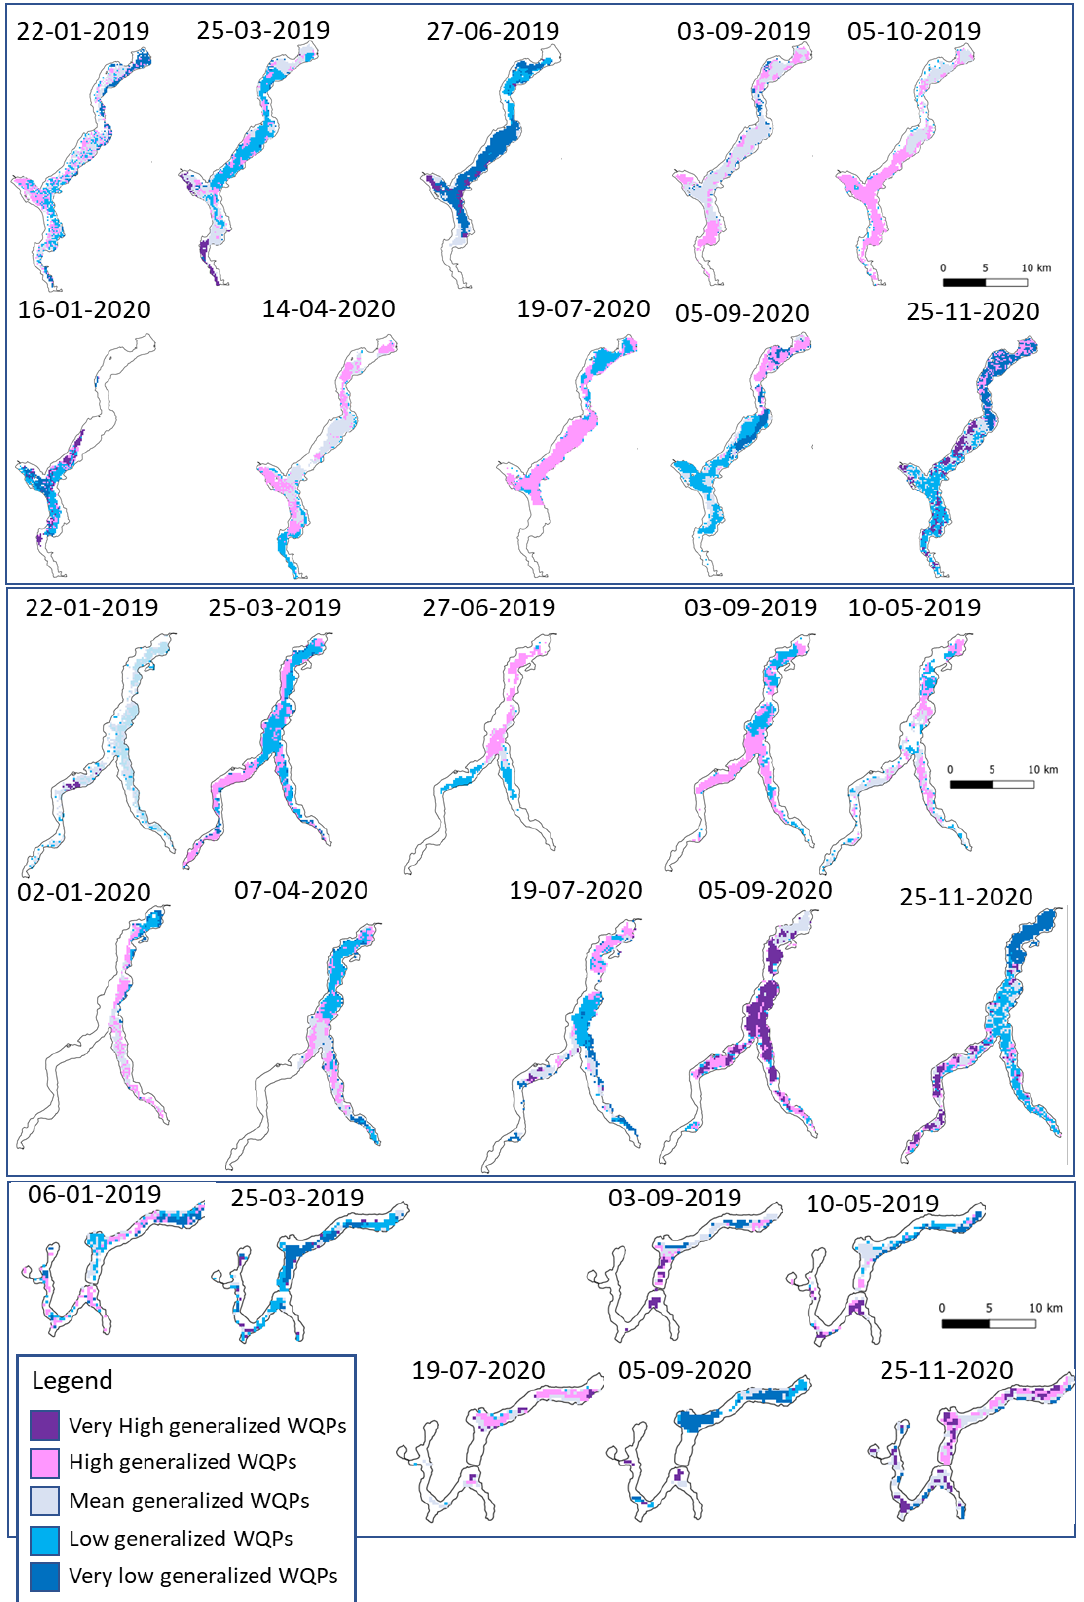
Figure 8. Time series clusters for lakes Maggiore, Como and Lugano for years 2019-2020. Position of lakes cluster maps is due to the date they are referred to. Particularly, lake Lugano lacks comprehensive information for the first semester of 2020. The legend is linked to the generalized combined mean WQPs values within each